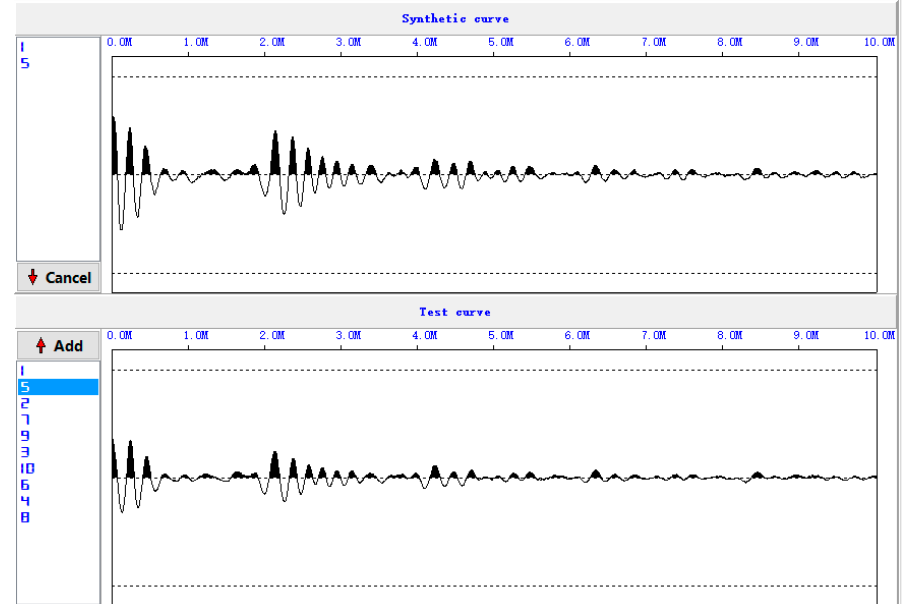
Figure 15. Superimposed waveforms at Site 2.